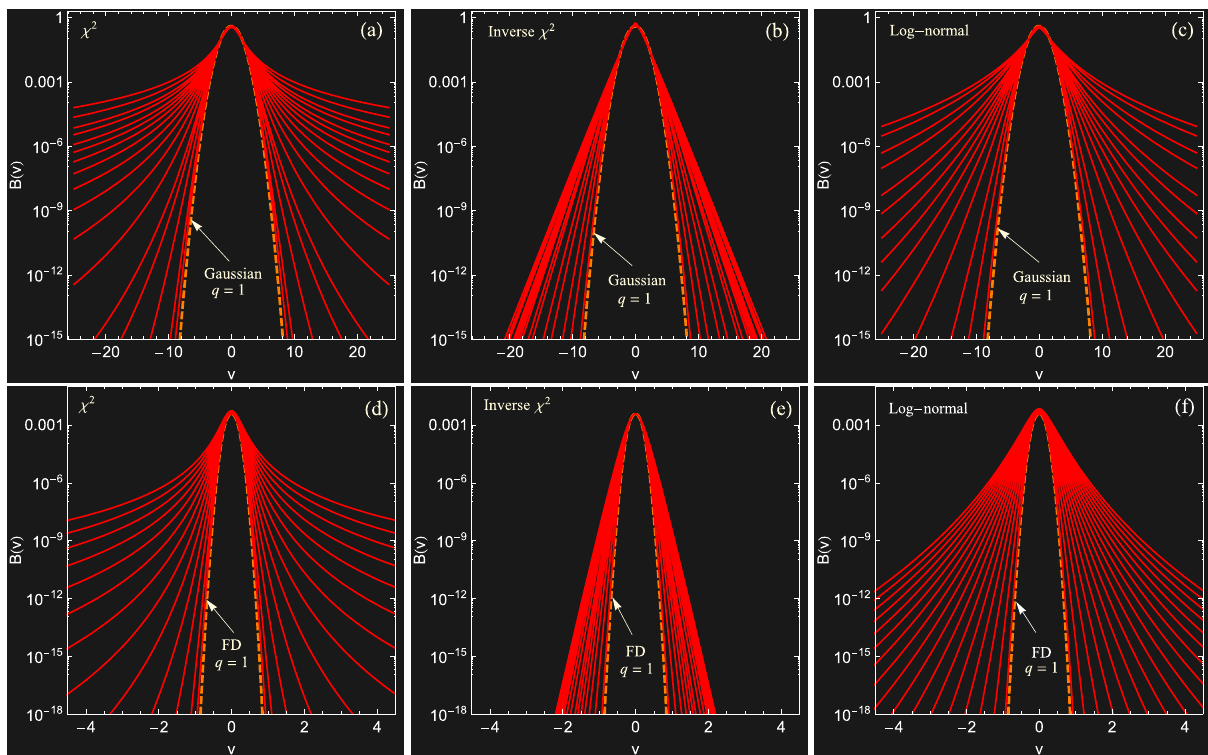
2 2 ( a , d ), inverse- χ ( b , e ), and log-normal ( c , β 2 /β 2 0 , in a logarithmic scale to better highlight the tails. In the := � �